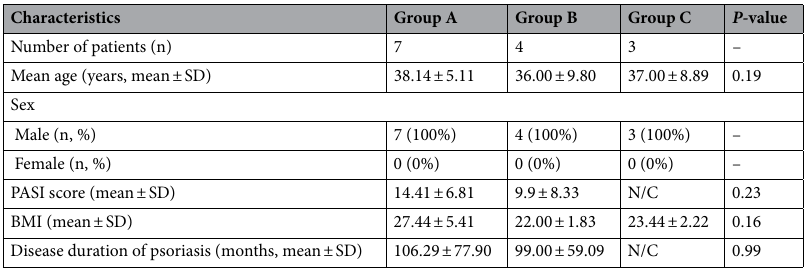
Table 1. The demographic data of participants in three groups. (Group A: psoriasis patients with CVD risk factors, Group B: psoriasis patients without CVD risk factors, Group C: healthy control). SD, standard deviation; PASI, psoriasis area severity index; BMI, body mass